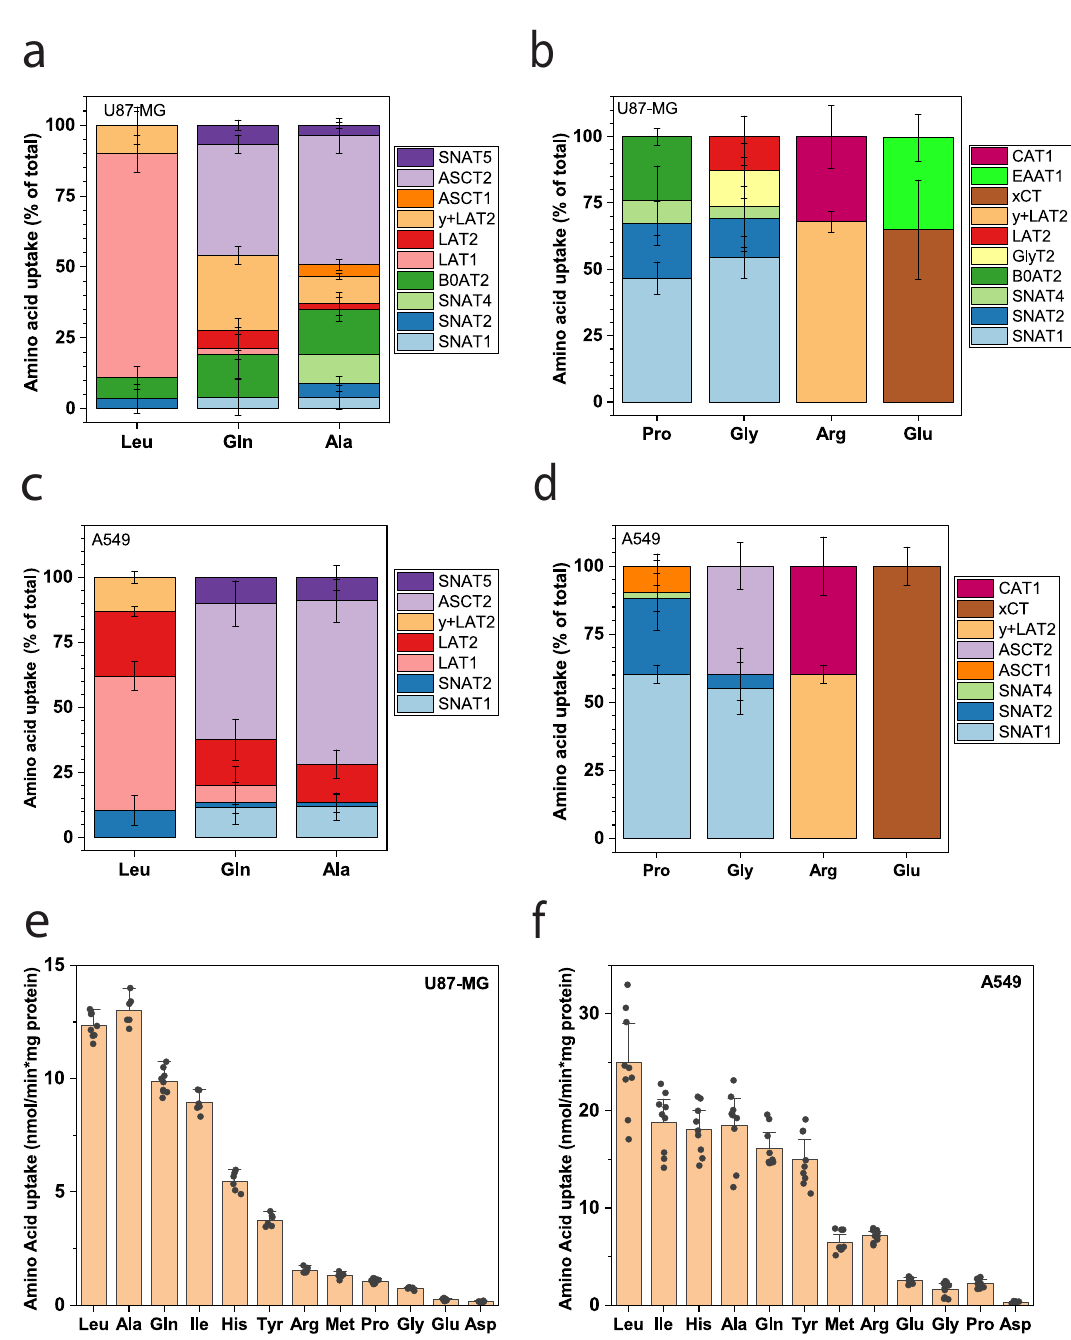
Fig. 4 Deconvolution of plasma membrane amino acid transport. Data from Figs. 1 and 2 were combined to illustrate the contribution of individual transporters to the uptake of the indicated amino acid. a , b AA transport activities in U87-MG cells are shown, c , d shown in A549 cells. a , c High-capacity transporters are shown, b , d low-capacity transporters are shown. Data are shown as mean ± STD, the number of biologically independent samples is the same as reported in Figs. 2 and 3. To compare the uptake activity for a variety of amino acids, uptake was measured at 100 µ M in U87-MG cells ( e , n = 9 biologically independent samples from e = 3 independent experiments) and A549 cells ( f , n = 9 biologically independent samples from e = 3 independent experiments). 95% Con fi dence intervals are shown for each bar. Color coding of all transporters is indicated in the legend next to the correlation plot between experimental and predicted values, giv- ing a Pearson ’ s correlation coef fi cient of 0.9996 for A549 cells and 0.9588 for U87-MG cells (Fig. S8a, b) over a concentration range from 100 to 16,000 μ M.